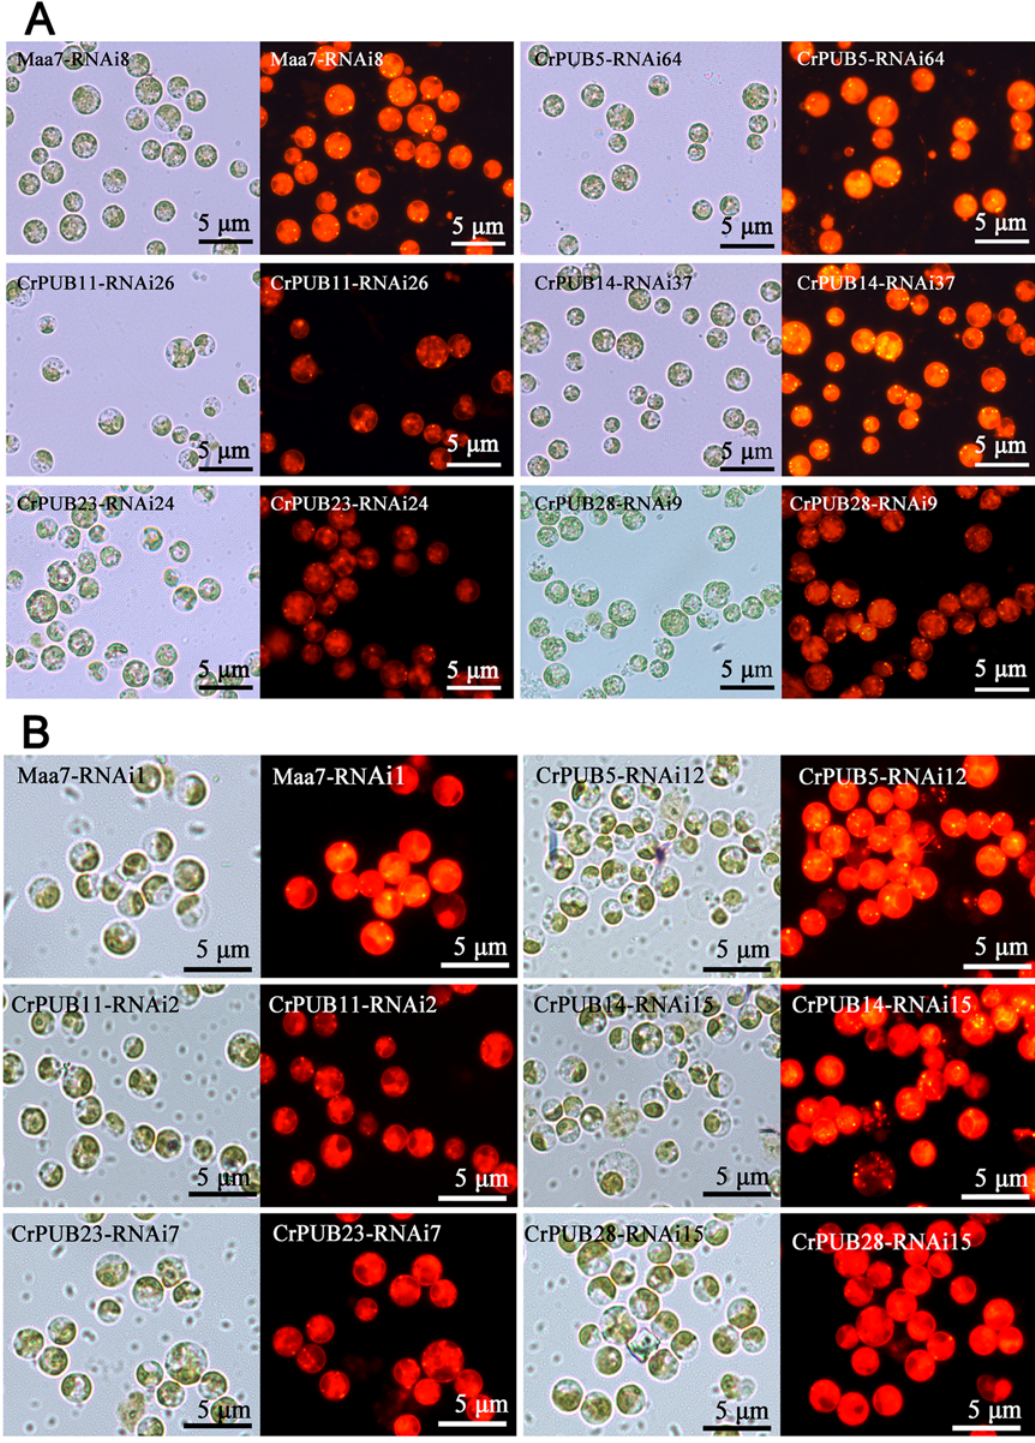
Fig 10. Microscopic observations of CrPUB gene RNAi transgenic algae. (A) Fluorescence microscopy for the detection of nonpolar lipid accumulation using Nile red staining of CrPUB RNAi lines containing the constructs harboring the fragments amplified using primer set A as the dsRNA. (B) Fluorescence microscopy for the detection of nonpolar lipid accumulation using Nile red staining of CrPUB RNAi lines containing the constructs harboring the fragments amplified using primer set B as the dsRNA. After culturing in HSM for 12 days, the cells of the RNAi lines were stained with Nile red and imaged using a Nikon 80i fluorescence microscope. Yellow fluorescence signals indicate lipid drops, while the red background indicates chlorophyll autofluorescence. Scale bars = 5 μ m. Each picture represents a bright field image (left) and a fluorescent image (right). doi:10.1371/journal.pone.0122600.g010 PLOS ONE | DOI:10.1371/journal.pone.0122600 March 30,